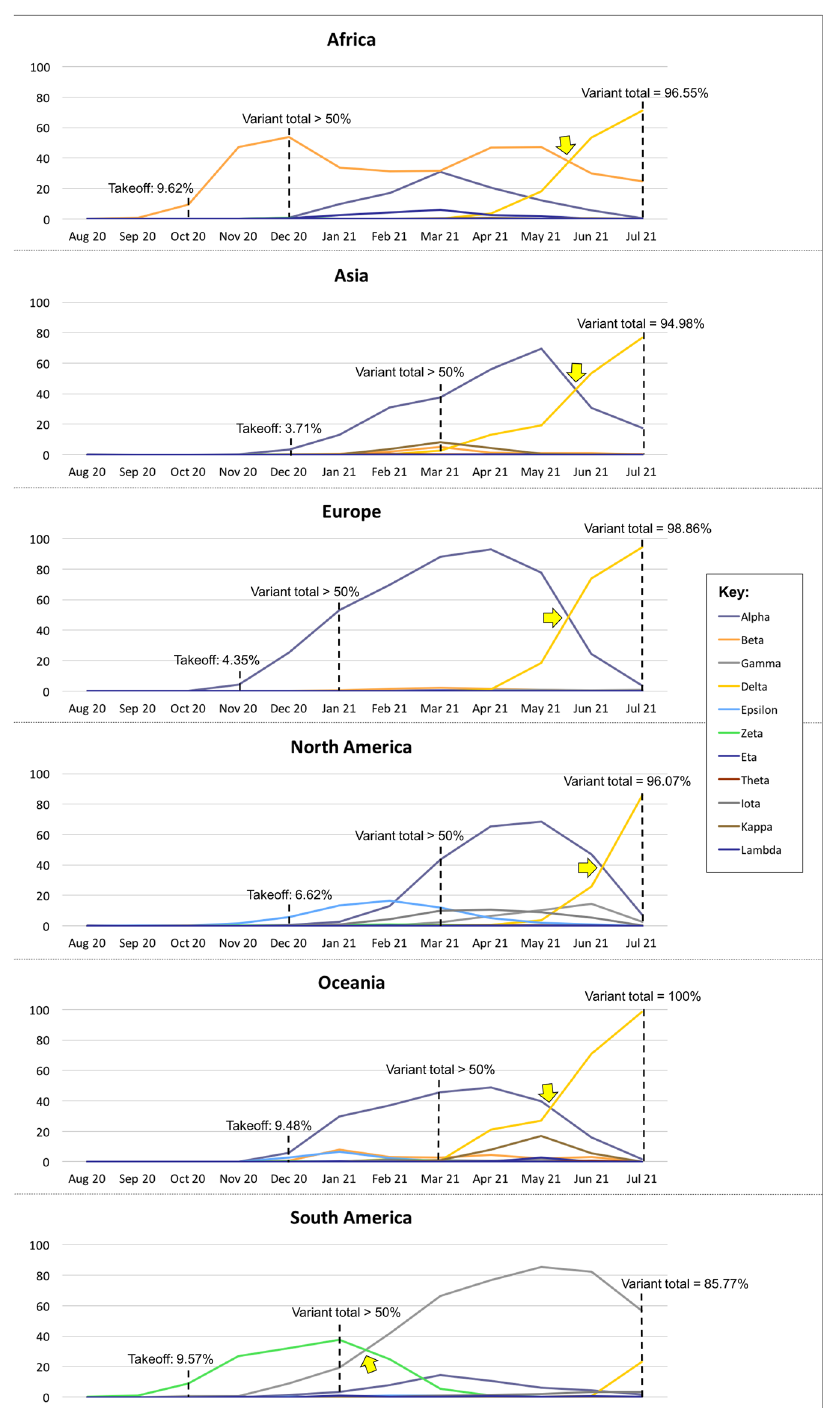
Figure 1. Proportions of SARS-CoV-2 variants collected in 6 continents throughout August 2020 to July 2021. The yellow arrows indicate the time points of major lineage interchange. Please note that owing to highly variable lag time between collection and submission dates, the latest situation in recent months (for instance, June and July 2021) might not be thoroughly